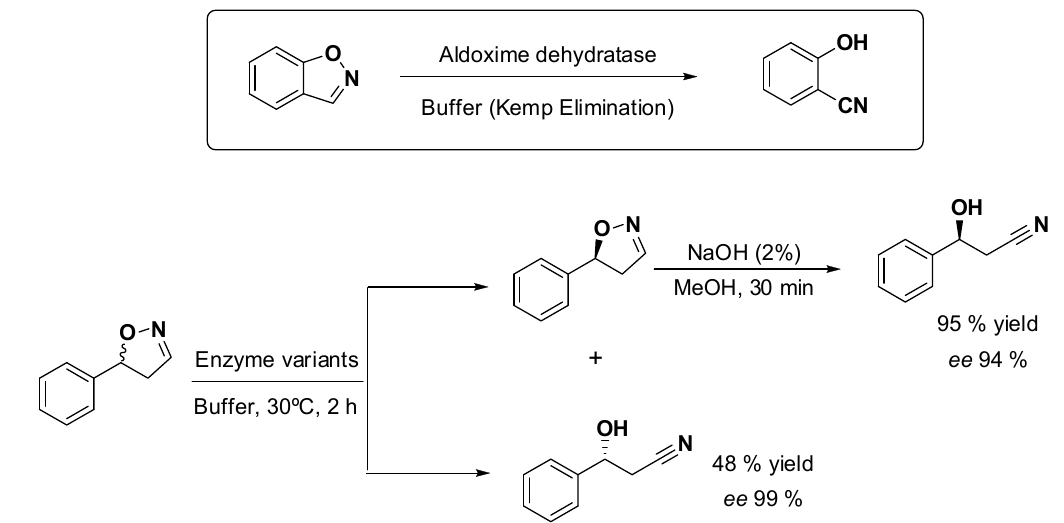
Scheme 2. Aldoxime dehydratase-catalyzed Kemp elimination (above) and use of it to synthetize chiral β -hydroxy-nitriles, reported by the Asano group [21,22].